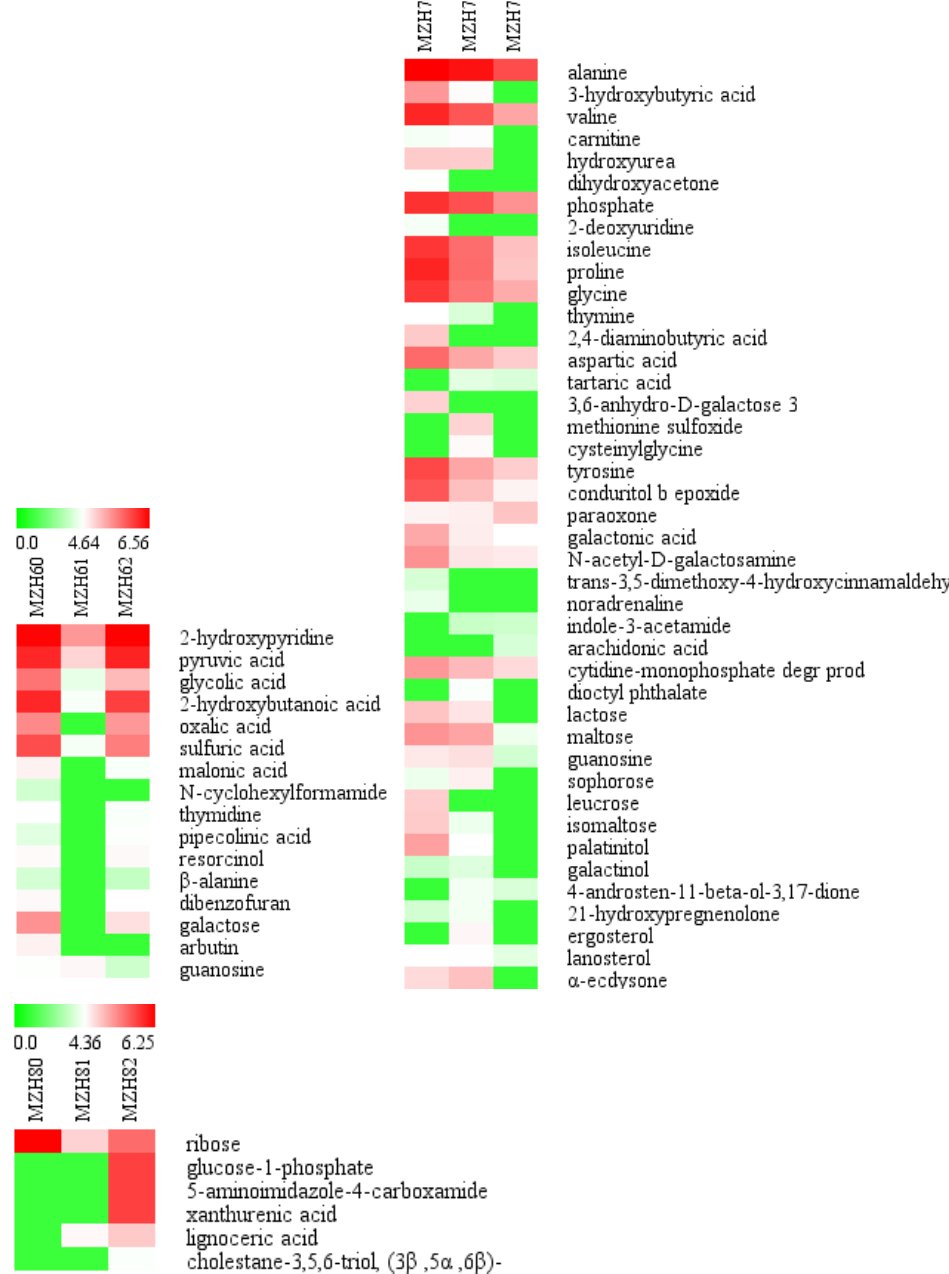
Figure 8. Heatmap of the abundance of identified metabolites in the mycelia of Epichloë sinensis under selenium concentrations in a given cultivation time. Red and green blocks indicate higher or lower metabolite levels (see scale bar). MZH40, MZH41, and MZH42 represent mycelia grown for 4 weeks in the presence of 0, 0.1, or 0.2 mmol/L Na 2 SeO 3 , respectively. MZH50, MZH51, and MZH52 represent mycelia grown for 5 weeks in the presence of 0, 0.1, or 0.2 mmol/L Na 2 SeO 3 , respectively. MZH60, MZH61, and MZH62 represent mycelia grown for 6 weeks in the presence of 0, 0.1, or 0.2 mmol/L Na 2 SeO 3 , respectively. MZH70, MZH71, and MZH72 represent mycelia grown for 7 weeks in the presence of 0, 0.1, or 0.2 mmol/L Na 2 SeO 3 , respectively. MZH80, MZH81, and MZH82 represent mycelia grown for 8 weeks in the presence of 0, 0.1, or 0.2 mmol/L Na 2 SeO 3 , respectively.